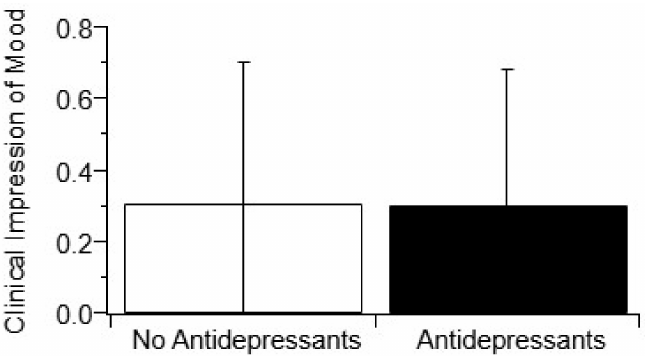
Figure 1. The use of antidepressants does not improve Clinical Impression of Mood (CIM). CIM was classified at each clinic visit using a published binary assessment [20] based on visual and verbal ques, as detailed in the Methods. All antidepressant interventions in a patient’s chart were recorded on a per-visit and per-patient basis. The use of antidepressants (n = 458) did not have a significant e ff ect on